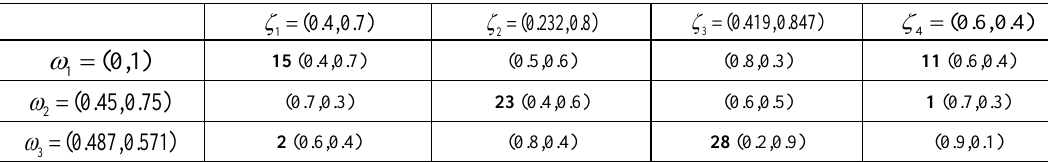
Table 3. First table for finding opportunity cost.